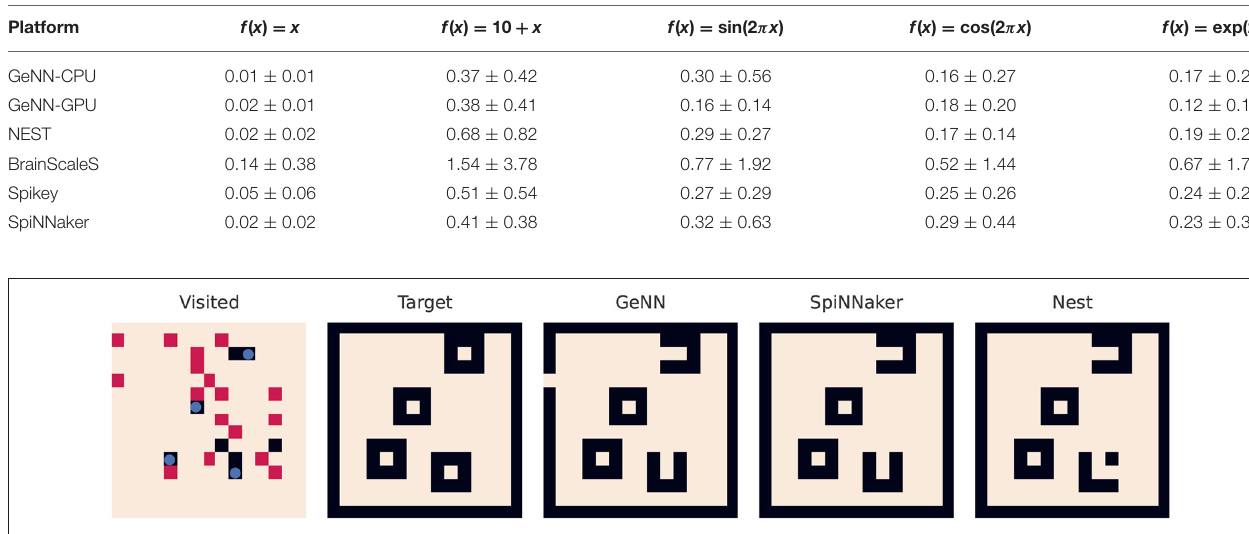
TABLE 4 | Average deviations for selected functions in the function approximation benchmark.